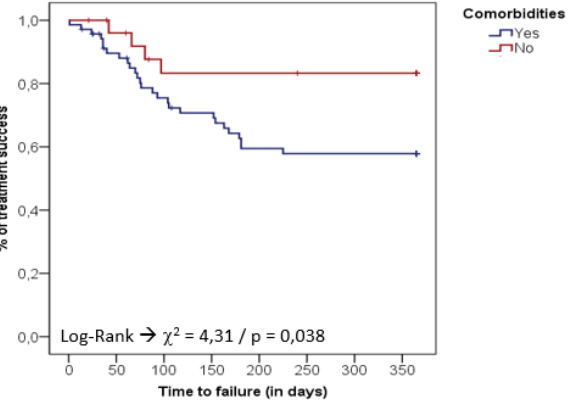
Figure 2. Kaplan–Meier survival curve for treatment failure (death/recurrence) among PJI patients with and without comorbidities.